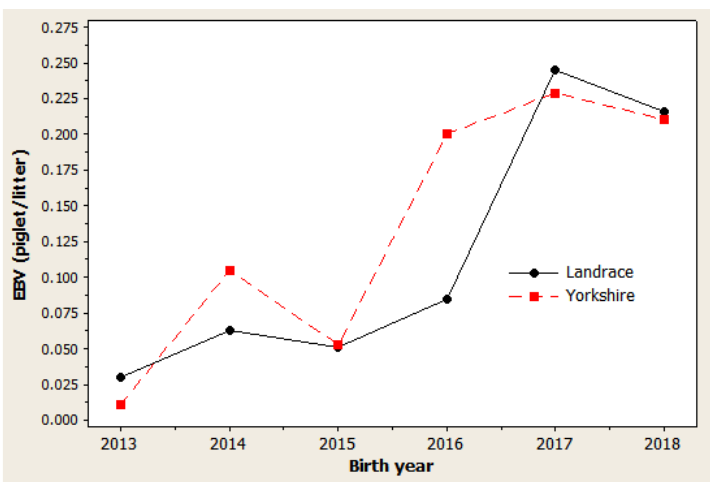
Figure 1. Genetic trend of number born alive in Danish Landrace and Yorkshire pigs by year of birth. Regression coefficients were 0.0431 piglet/yr (p = 0.021) for Landrace and 0.0434 piglet/yr (p = 0.019) for Yorkshire pigs.